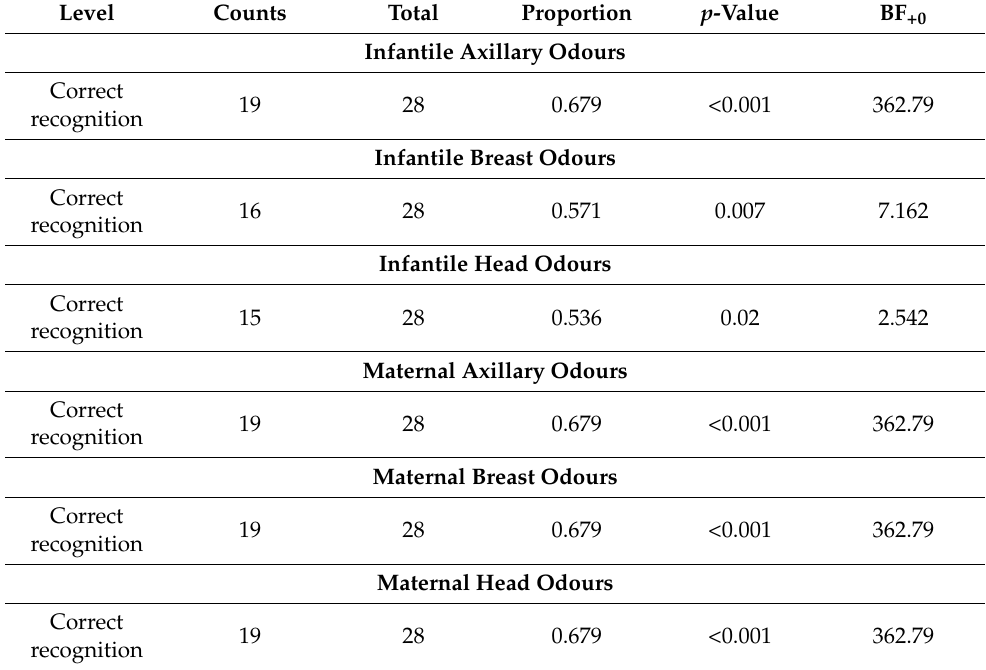
Table A7. Overview of p -values and BF + 0 factory for binomial tests. Counts mean the number of correct recognitions of the familiar BO sample out of a total of 28 samples for each body site. This results in the proportion of correct recognitions. The p -value indicates whether the proportion is significantly different from the proportion expected by chance (i.e., 0.33). The Bayes Factor BF + 0 indicates how likely it is that the alternative model (i.e., there is a difference of proportion) explains the data compared to the null model (i.e., there is no difference, the familiar samples were only recognised as well as expected from chance) explaining the